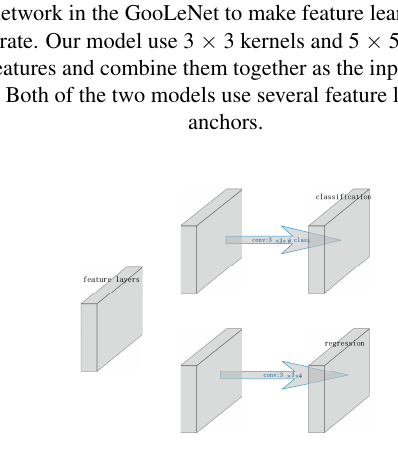
Where the L conf means the loss of classification and the L loc means the loss of regression. N is the number of matched de- fault anchor boxes. The confidence loss is the softmax loss and the regression loss is the smooth loss defined in Faster R-CNN [5]. In order to solve the extreme foreground-background class imbalance problem, we calculate the classification loss function of positive and negative samples with a ratio of 1:5, i.e., choosing the negative samples with the greatest loss to achieve the ratio. The regression function only works for anchors with